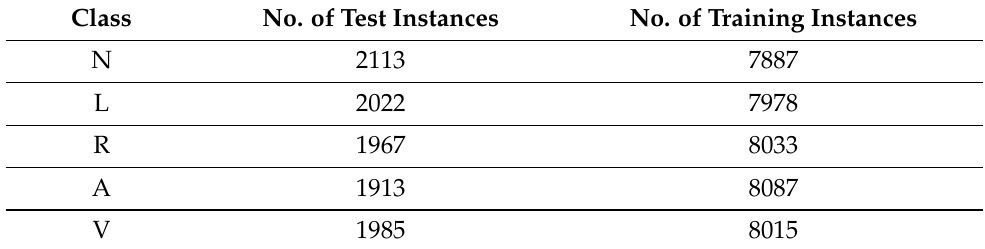
Table 9. Training and Testing Data